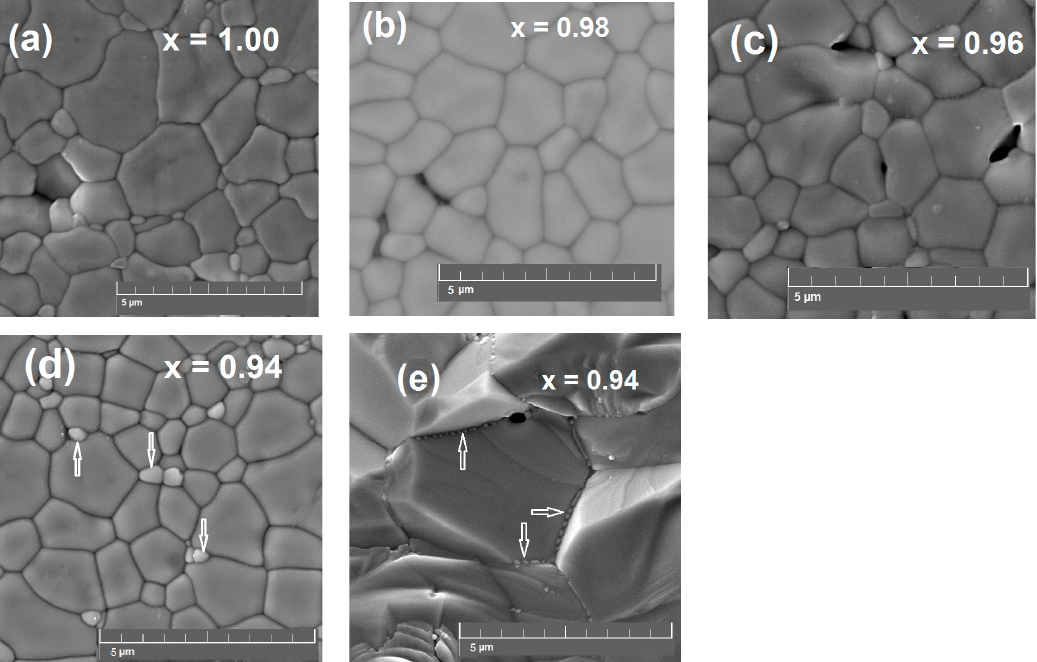
Figure 2. SEM images of Sr x Zr 0.95 Yb 0.05 O 3– δ : the surface of ( a ) x = 1.00, ( b ) 0.98, ( c ) 0.96 and ( d ) 0.94 samples after polishing and thermal etching, ( e ) fracture of the x = 0.94 sample. The impurity phase grains are marked with arrows.